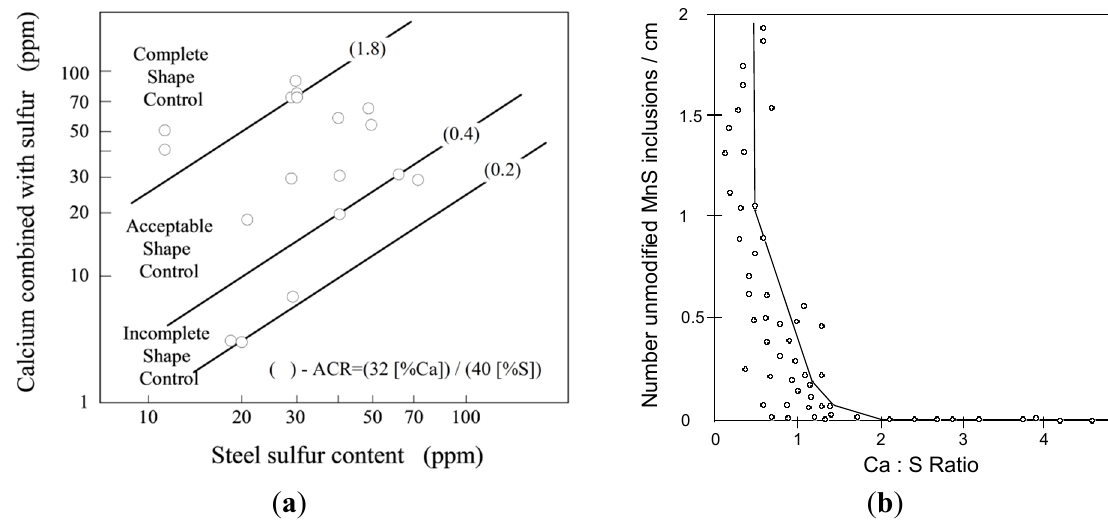
Figure 17. ( a ) Shape control of sulfides due to calcium addition in HSLA steel [58]; ( b ) Ca/S ratio given in wt.% correlated to the number of unmodified MnS inclusions/cm in low sulfur carbon steel